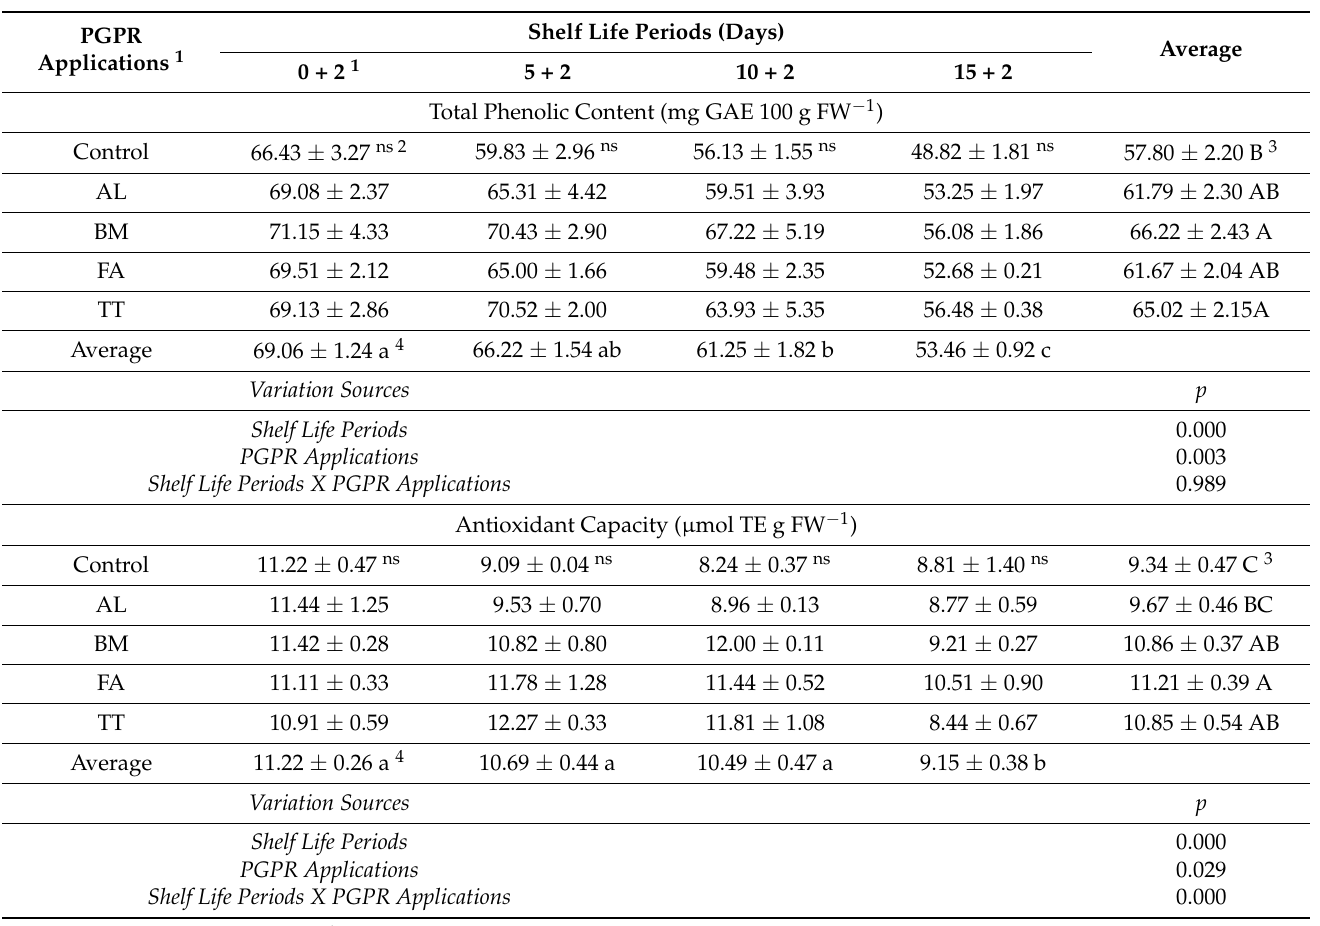
Table 5. The effect of different PGPR applications on total phenolic content and antioxidant capacity in white button mushroom during shelf life